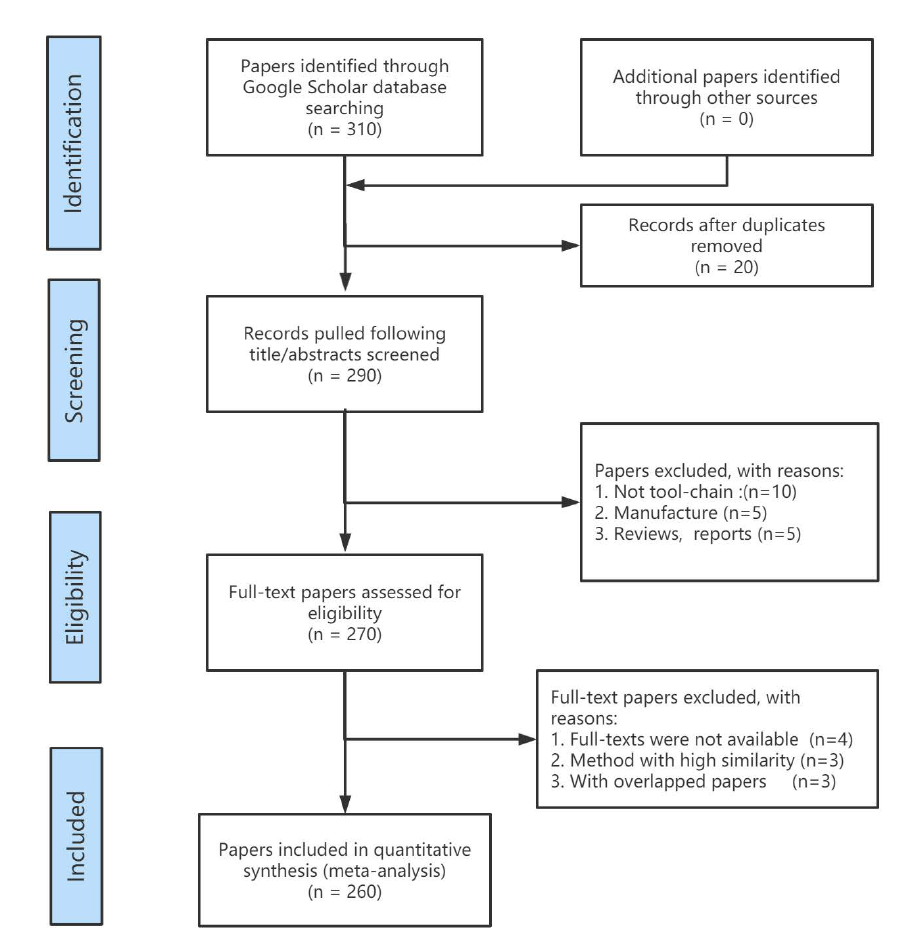
Figure 1. PRISMA flow